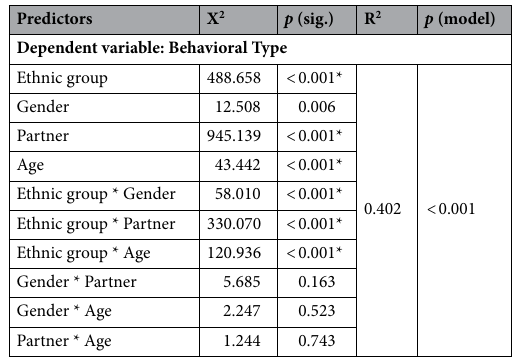
Table 3. Effects of ethnicity, gender, age and interaction partner on behavior in the games. Multinomial logistic regression: overall effects. R 2 – Nagelkerke R 2 ; statistically highly significant effects are marked with *